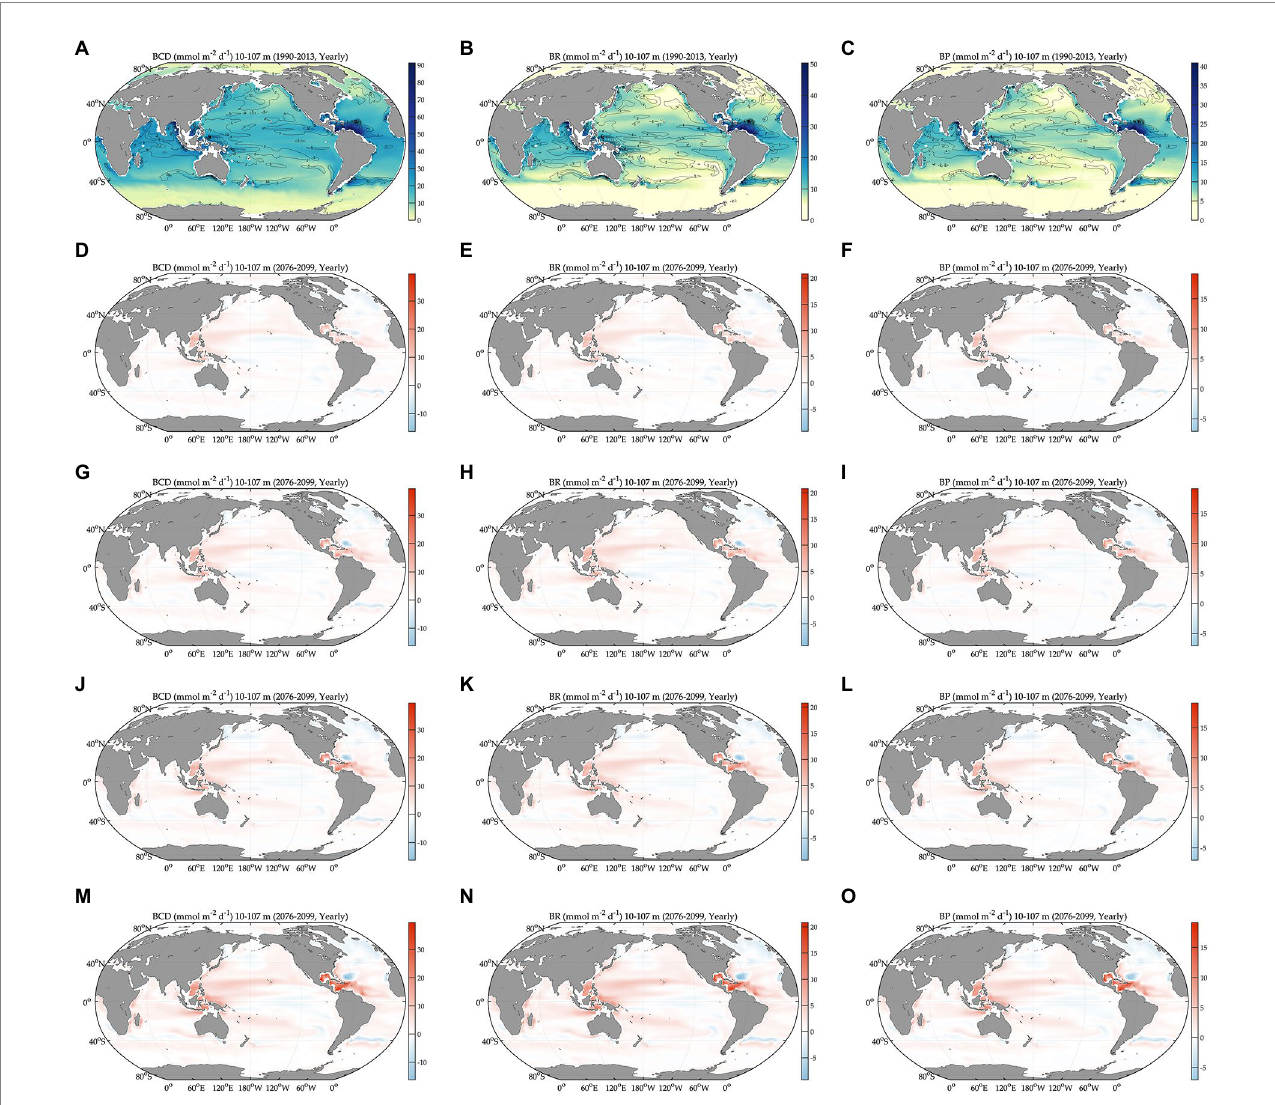
FIGURE 2 Global projections of bacterial carbon rates during the baseline period (1990–2013) and their anomalies under different climate change scenarios relative to the baseline period (2076–2099). BCD: bacterial carbon demand, BR: bacterial respiration, and BP: bacterial production. Bacterial carbon demand during the baseline period (A) and its change relative to (A) under different SSPs (D,G,J,M) . Bacterial respiration during the baseline period (B) and its change relative to (B) under different SSPs (E,H,K,N) . Bacterial production during the baseline period (C) and its change relative to (C) under different SSPs (F,I,L,O) . The figures are in the order of increasing SSPs from top to